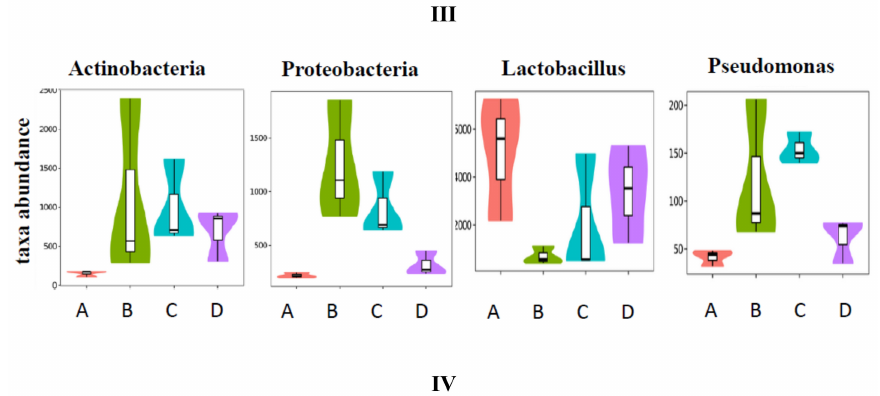
Figure 6. SCPE modulated the HFD-disrupted gut microbiota composition. I: unweightedUniFrac NMD analysis. II: the significantly different species in four groups. III: the relative abundance (%) of bacterial at family level in four groups. IV: Highly differentiated OTU at phylum and genus levels in four groups. A: LFD; B: HFD; C: HFD + LE; D: HFD + HE. Different lower-case letters correspond to significant differences at p <